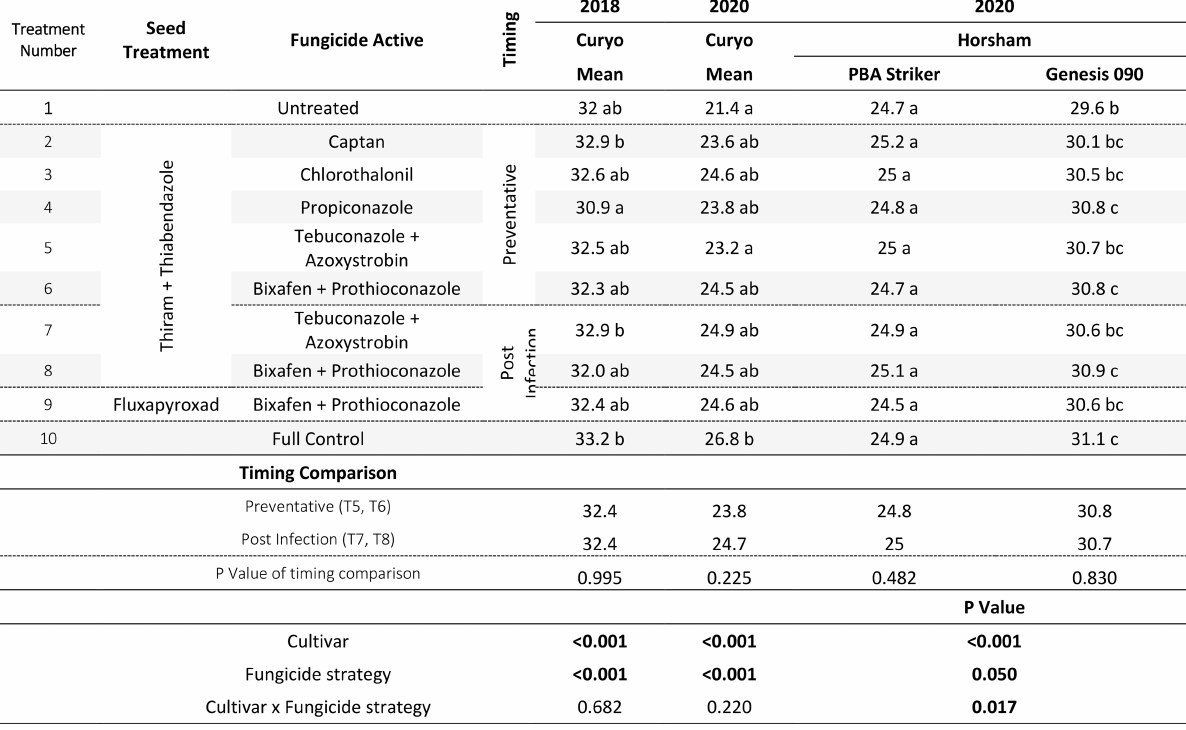
Significant values are